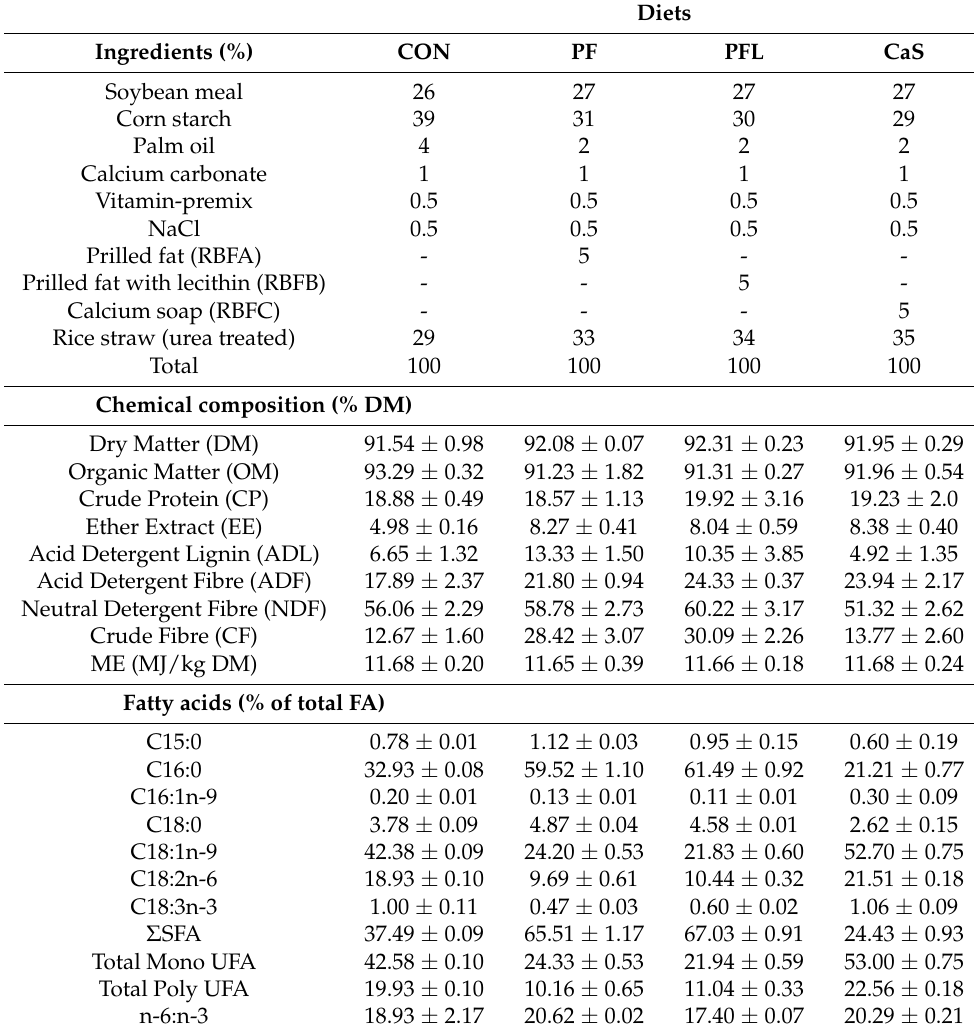
Table 2. Ingredients, chemical composition and fatty acid profile of